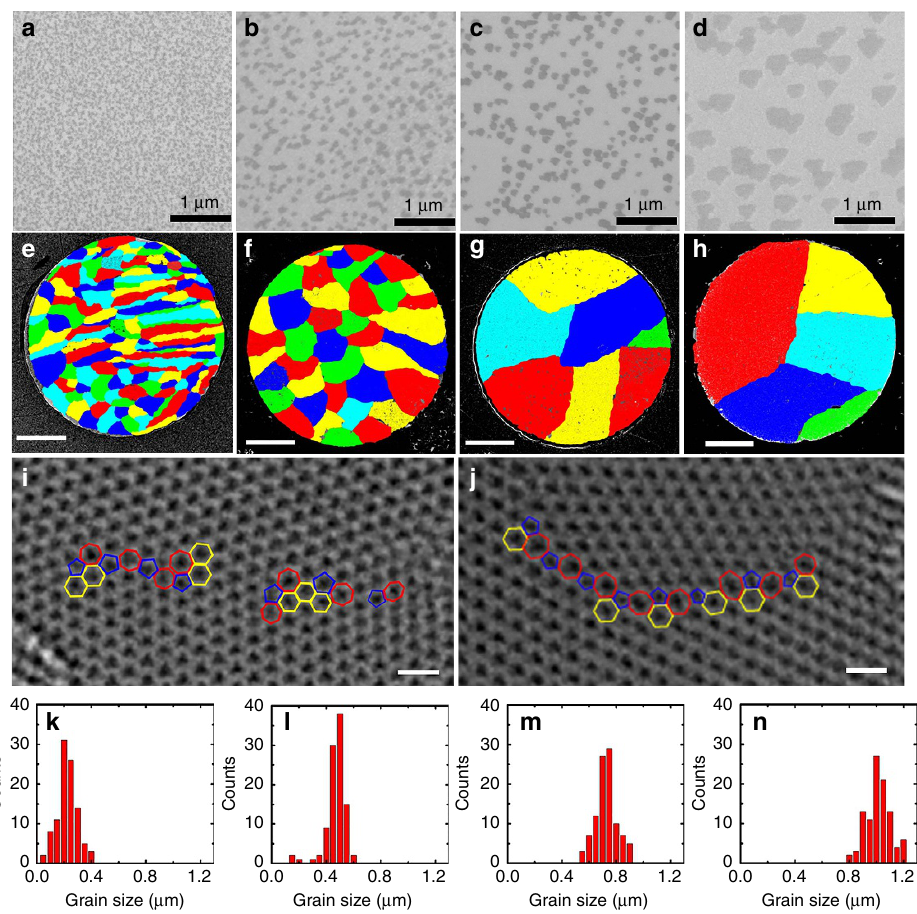
Figure 2 | Structural characterization of graphene domains and films. ( a – d ) SEM images of graphene domains obtained with a segregation temperature of 900, 950, 1,000 and 1,040 (cid:2) C, showing that the domain density decreases with segregation temperature. ( e – h ) False-colour, dark-field image overlays of the graphene films formed by growth and stitching of the graphene domains in a – d . Scale bars, 500nm. ( i , j ) High-magnification HRTEM images of graphene films with grain size of B 200 and B 700nm, respectively. The pentagons (blue), heptagons (red) and hexagons (yellow) in the GBs are outlined. All images were processed with an improved Wiener-filtering to remove the noises. Scale bars, 1nm. ( k – n ) Histograms of grain sizes of the graphene films in e – h , showing that the grain size is very uniform for each